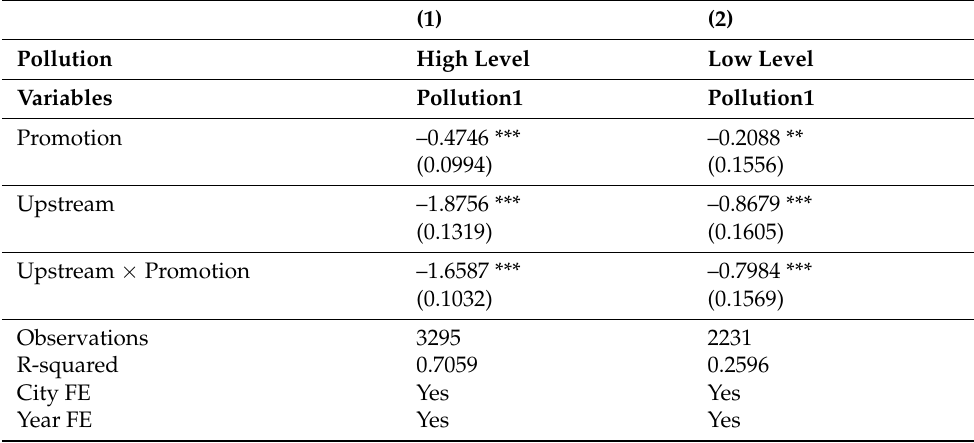
Table A4. Effects of promotion under high and low pollution.